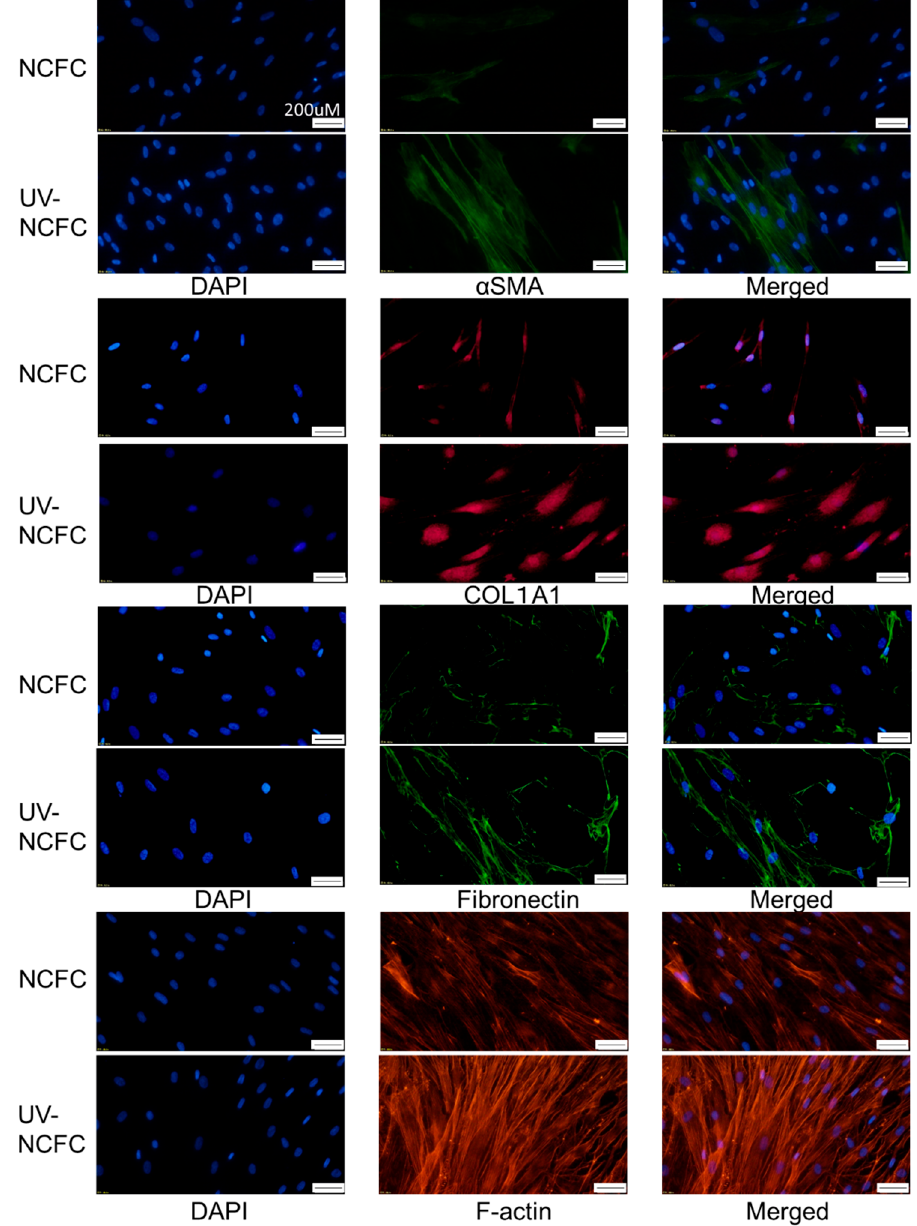
Figure 10. Immunocytochemistry of α -SMA, COL1A1, fibronectin, and F-actin in NCFCs and UV-NCFCs. The left panels show cells that stained with DAPI. The middle panels show cells stained for either α -SMA, COL1A1, fibronectin, or F-actin. The right panels show a merged image. These components were upregulated in UV-NCFCs compared to NCFCs. Bar, 200 µm.